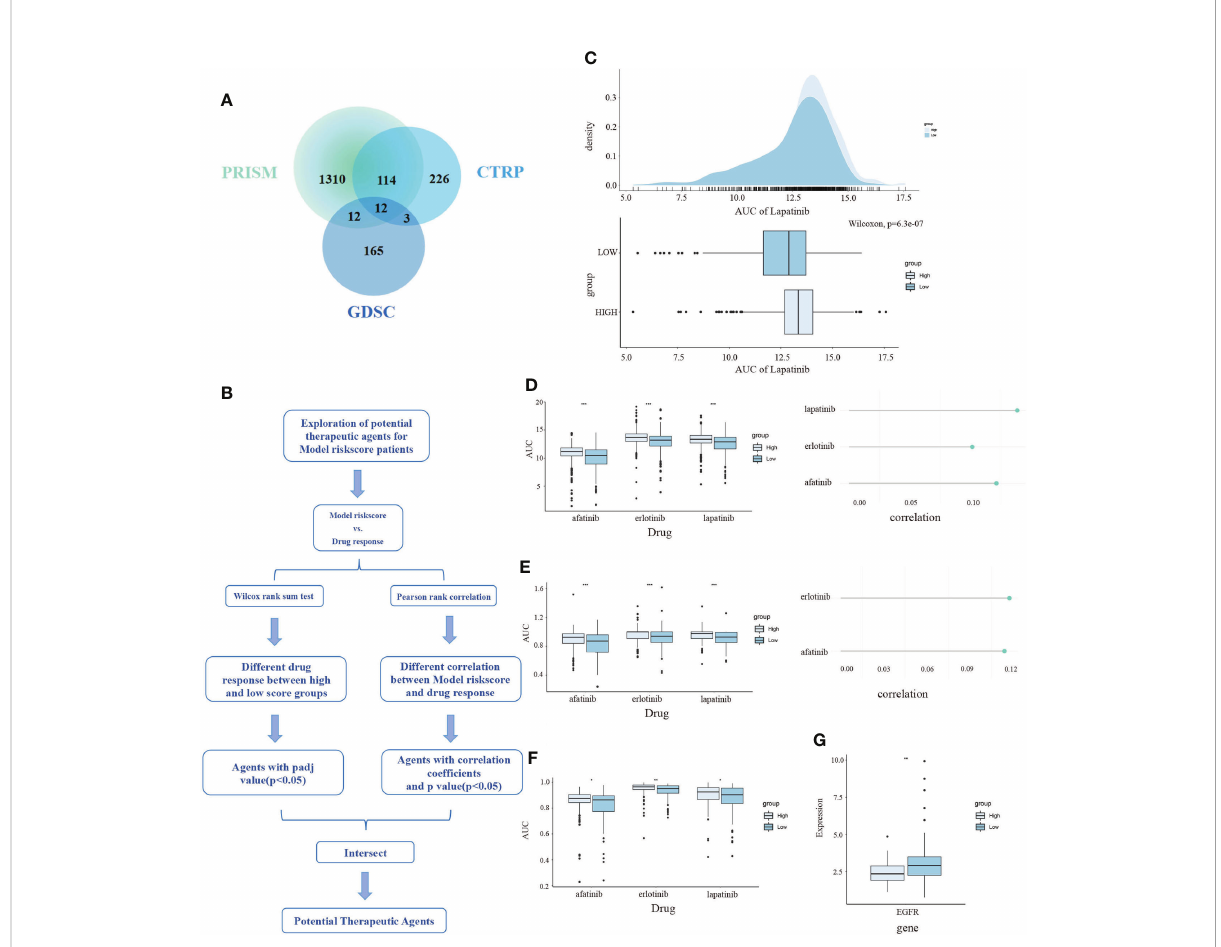
FIGURE 7 The exploration of potential targeted drugs based on the CDKN2A-derived model for TNBC patients. (A) The shared drug between PRISM, GDSC and CTRP. (B) The fl ow chart of exploring potential therapeutic agents. (C) The AUC of lapatinib in high and low risk score subpopulations of TNBC patients. (D – F) The AUC of three selected drugs in high and low risk score subpopulations of TNBC patients. (G) The relationship between AUC values and targets of three drugs. The P values of the fi gure are shown as follows: *P < 0.05. **P < 0.01. ***P <